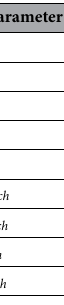
Table 1. Design parameters of the cavity shown in Fig. 2a.